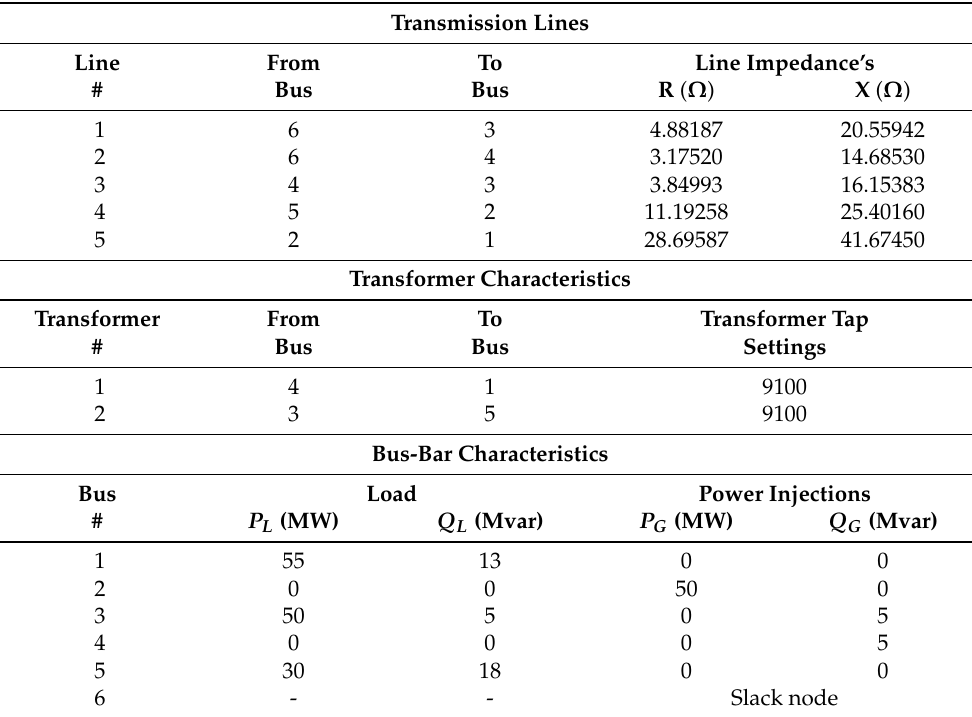
Table 1. Electrical data of the IEEE 6-bus test system.